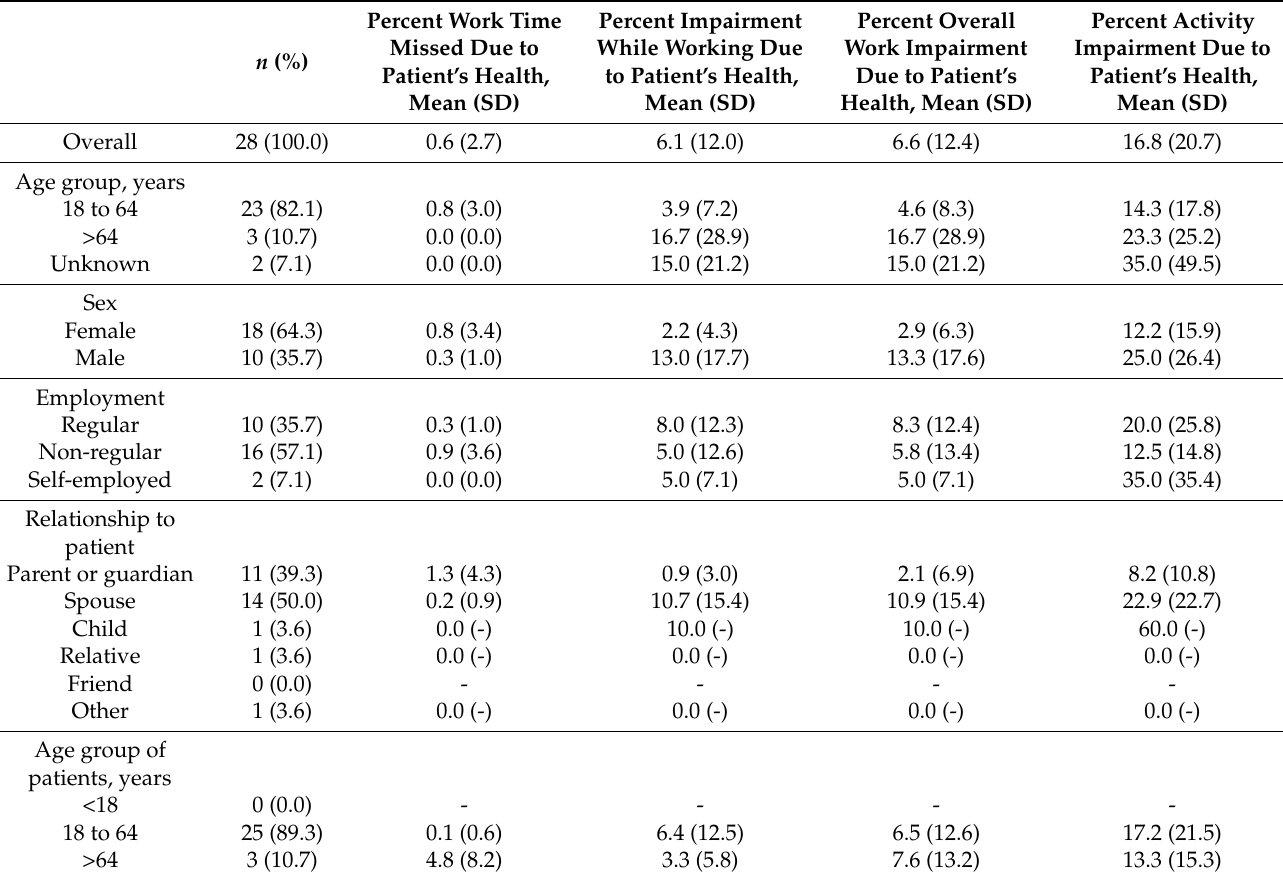
Table 2. Work productivity and activity impacts on caregivers of patients with retinitis pigmentosa.